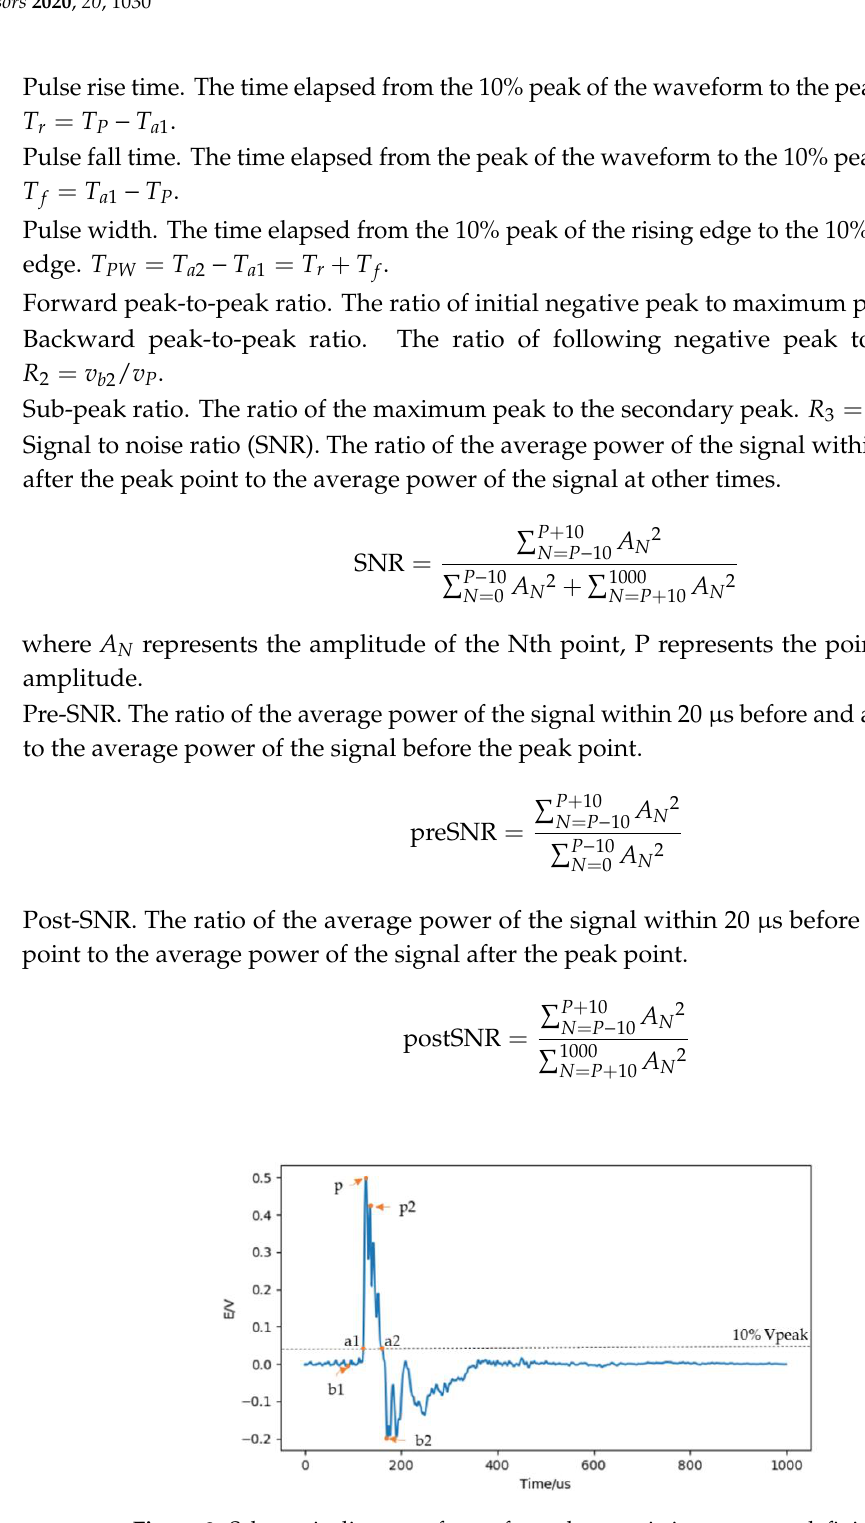
Table 4. Results of statistical classification.